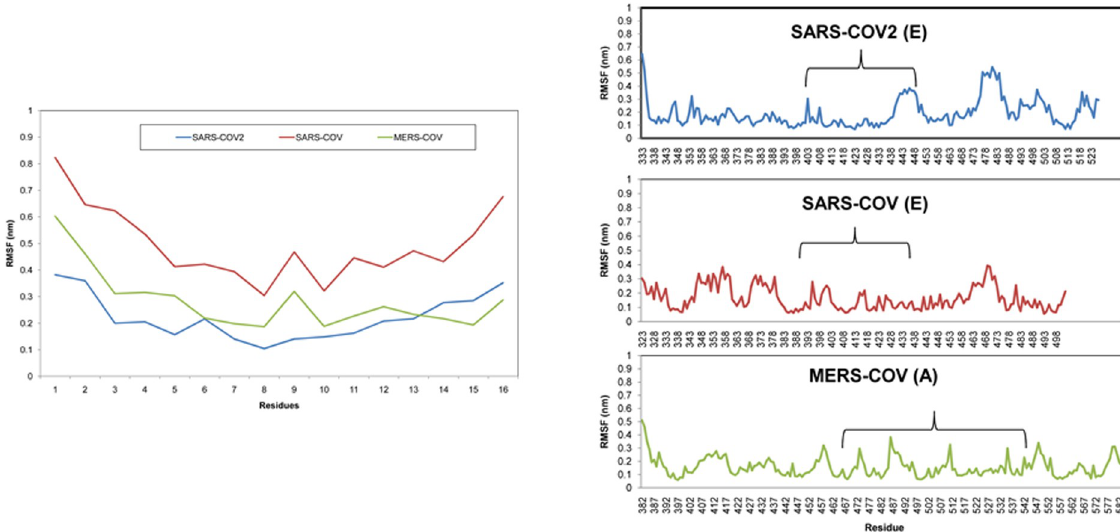
Fig 11. (a) RMSF of Peptide 7 in the Peptide 7- RBD complex. (b) RMSF of the RBD in the Peptide 7-RBD complexes. Brackets show the regions where Peptide 7 binds to the RBD.